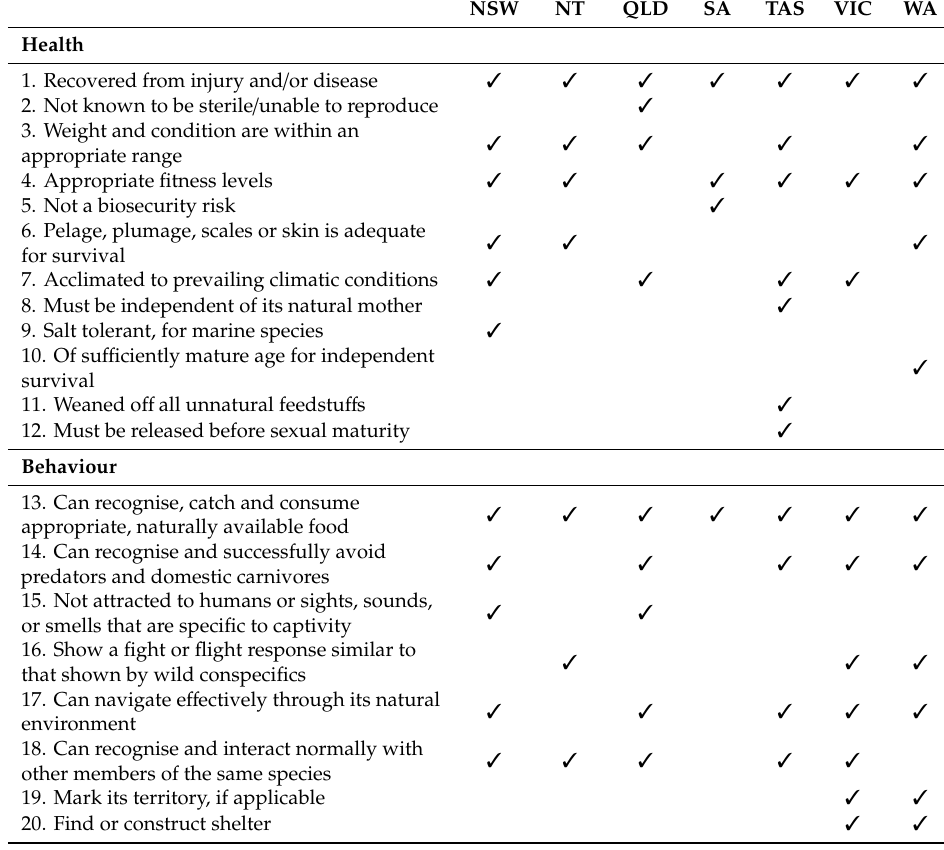
Table 8. Standards of health and behaviour required of rehabilitated wildlife in various jurisdictions prior to release in